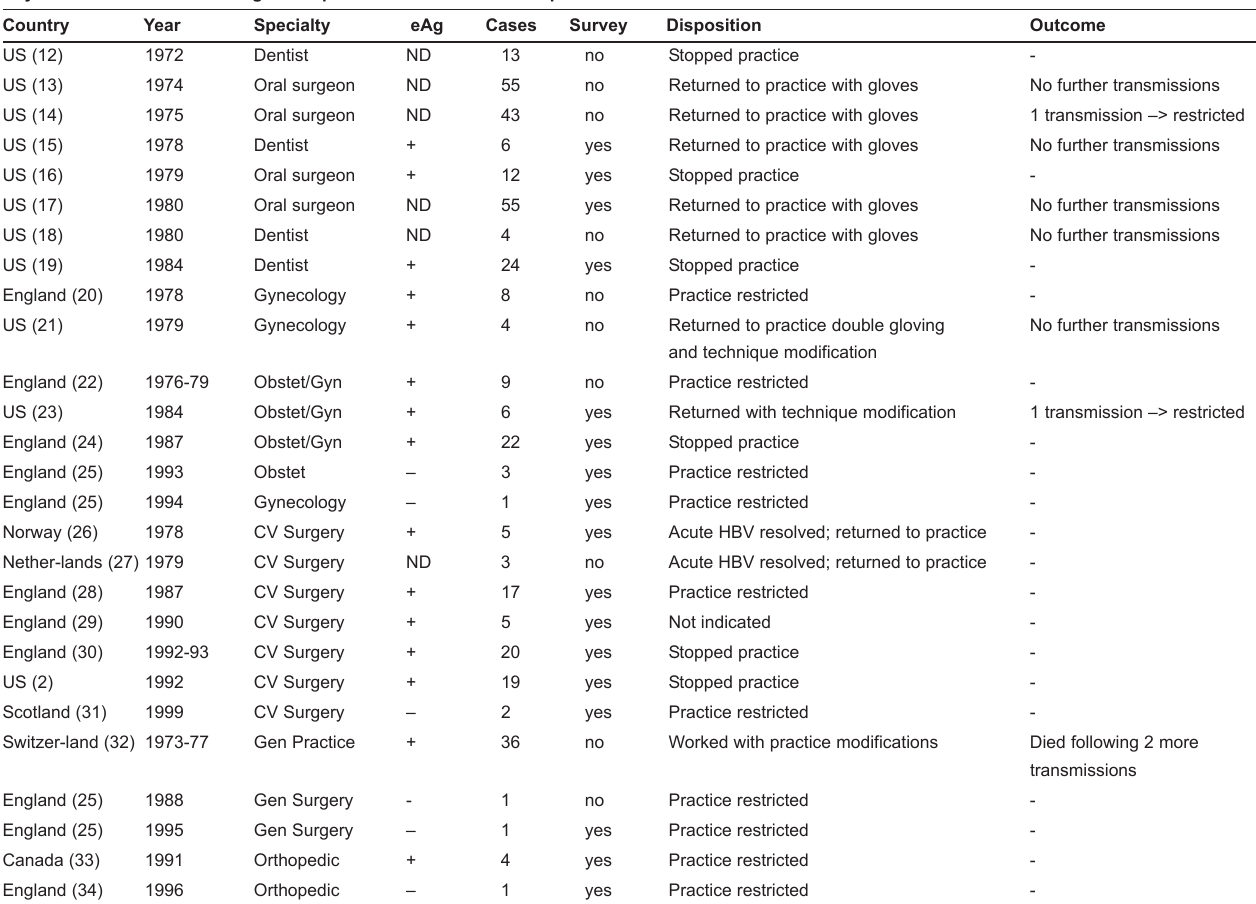
Physician and dentist/oral surgeon-to-patient transmissions of hepatitis B